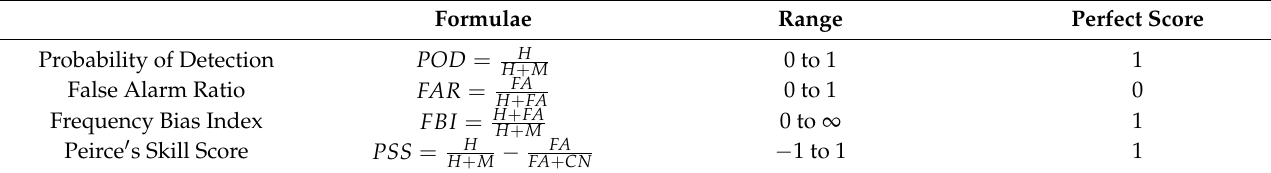
Table 2. Formulae, range, and perfect score of four categorical skill metrics used in this study. H (Hits) is the number of events when both IMERG and rain-gauge-based products detect rainy days, FA (False Alarms) is the number of events when only IMERG detects rainy days, M (Misses) is the events when only rain-gauge-based product detect rainy days, and CN (Correct Negatives) is the number of events when both IMERG and rain-gauge-based products detect non-rainy days. Formulae Range Perfect Score Probability of Detection POD = H 0 to 1 1 H + M False Alarm Ratio FAR = FA 0 to 1 0 H + FA Frequency Bias Index FBI = H + FA 0 to ∞ 1 H + M Peirce (cid:48) s Skill